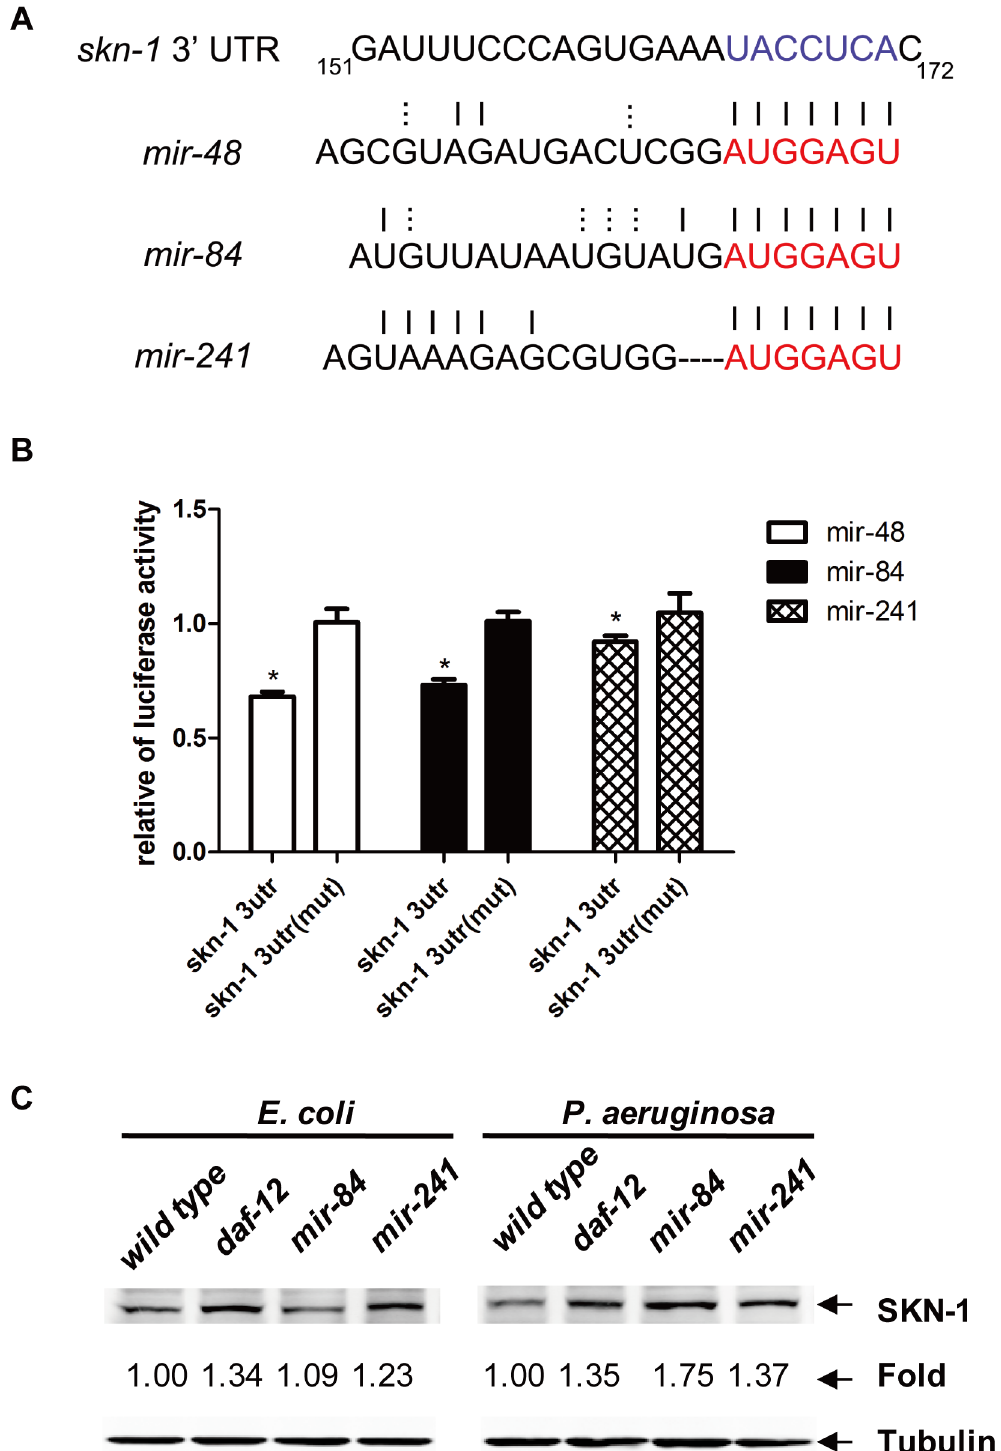
Figure 6. SKN-1 is a direct functional target of let-7s miRNAs. ( A ) Bioinformatics alignment of let-7s miRNAs and the 3 9 UTR of SKN-1. ( B ) Luciferase assays using the skn-1 3 9 UTR or the skn-1 3 9 UTR (mut) with let-7s mimics in HEK293T cells. The data shown are the mean 6 SEM of three independent experiments, each of which was performed in triplicate, * P , 0.05. ( C ) Immunoblot analysis of the lysates from N2, daf-12 (RNAi), mir- 84 ( n4037 ) and mir-241 ( n4316 ) worms on E. coli or P. aeruginosa using anti-SKN-1 antibody and anti-tubulin antibody (loading control).